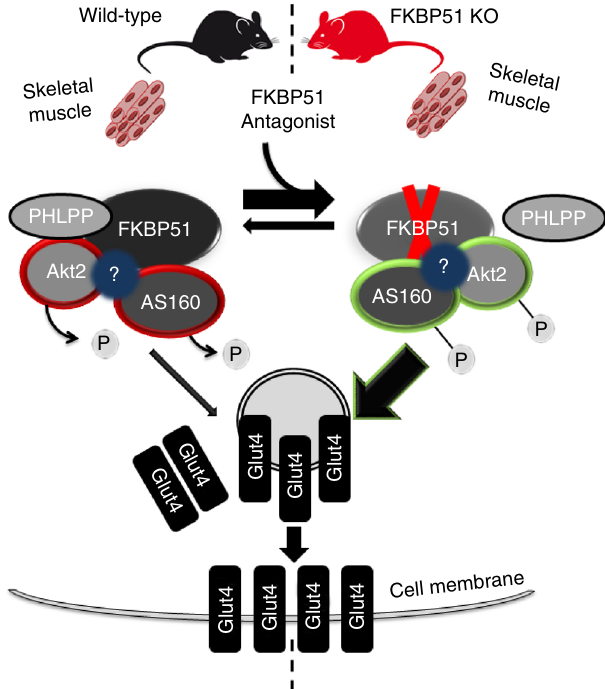
Fig. 7 Proposed model of FKBP51 as a regulator of glucose uptake. FKBP51 scaffolds Akt2, PHLPP1, and AS160. The associations between FKBP51, AKT2, PHLPP1, and AS160 may be either direct or indirect through additional intermediate proteins. In the presence of FKBP51, PHLPP1 phosphatase activity is directed towards AKT2 to favor inactive Akt2, decreased AS160 phosphorylation and reduced glucose uptake. By contrast, loss of FKBP51 ’ s scaffolding function leads to increased AKT2. In the presence of SAFit2, a conformational change within FKBP51 disrupts its ability to form a complex with AS160, while simultaneously enhancing AKT2-AS160 binding. Ultimately, loss of FKBP51 and FKBP51 antagonism with SAFit2 both promote glucose uptake. “ ? ” refers to possible unidenti fi ed intermediate proteins within the FKBP51 signaling complex. Curved arrows indicate PHLPP1-mediated dephosphorylation of AKT2 at Ser473. The green double arrow indicates enhanced binding between AKT2 and AS160. Green outlines re fl ect enhanced phosphorylation; red outlines re fl ect decreased phosphorylation. The width of the arrows correspond to the magnitude of downstream